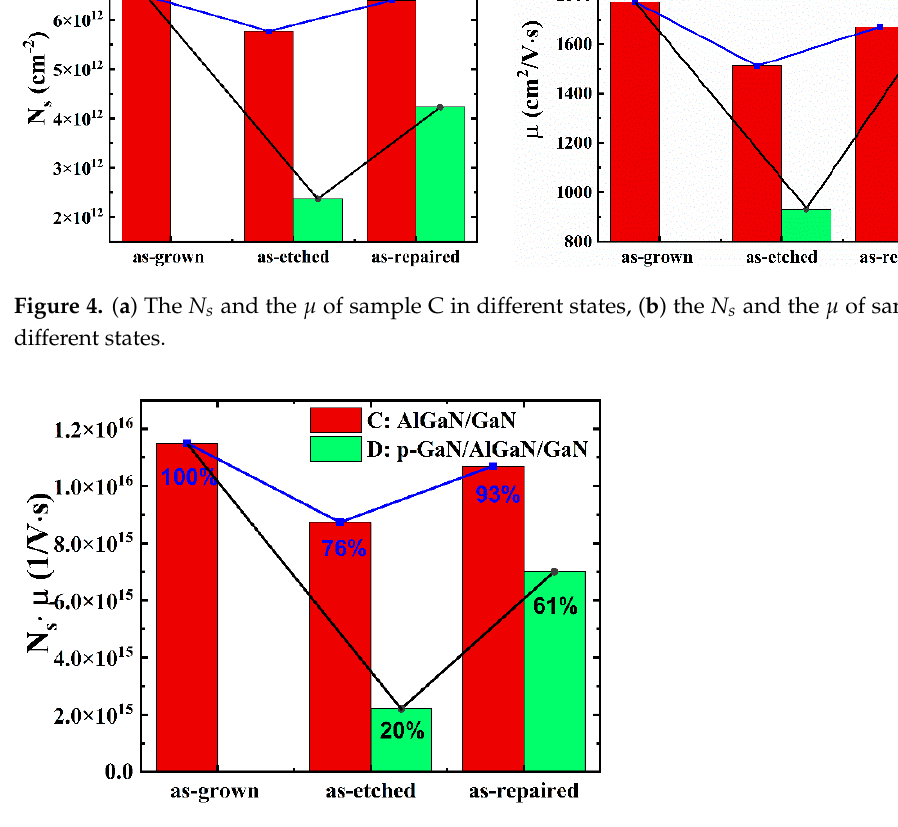
Figure 5. The product of the N s and the μ of sample C and sample D in different states.